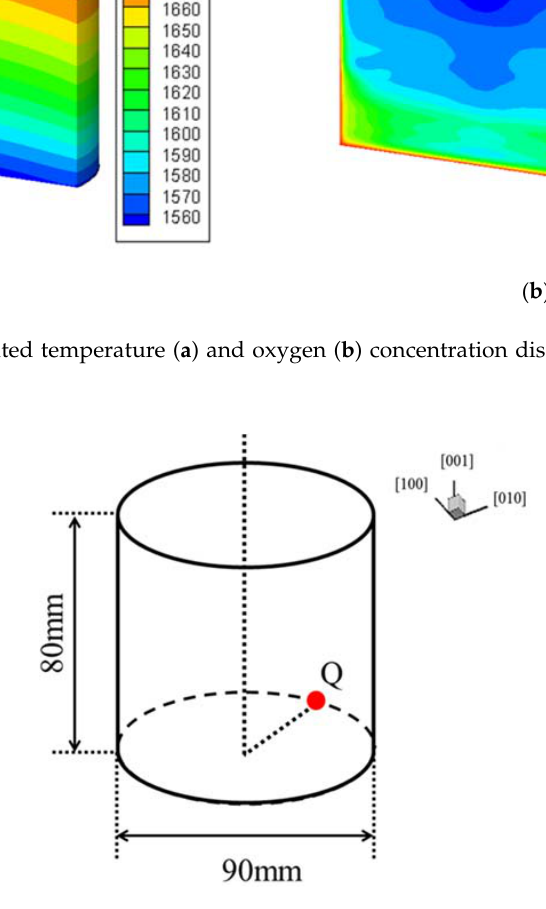
Figure 4. Schematic of a grown silicon crystal having a height of 80 mm and a diameter of 90 mm with monitoring point Q.